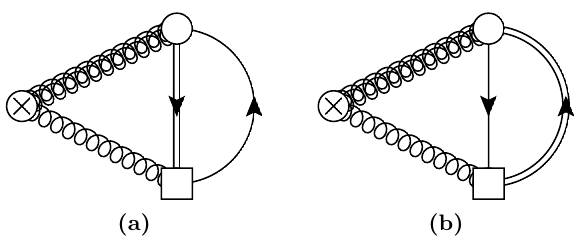
Figure 6. Diagrammatic representation of the contribution to h E i due to the sNMGF, whose total value is given in (4.14). (a) and (b) collectively represent E ∗